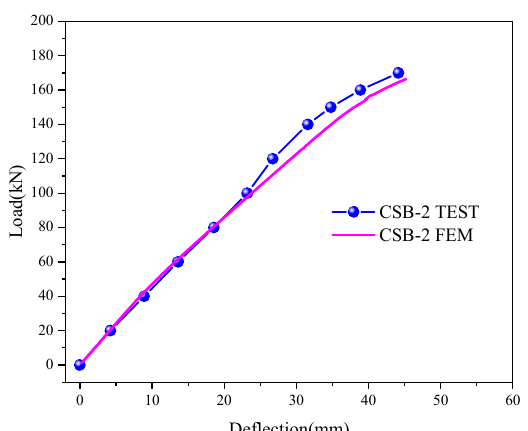
Figure 13. The overhanging end deflection of test value and FEM calculated value of CSB-2.